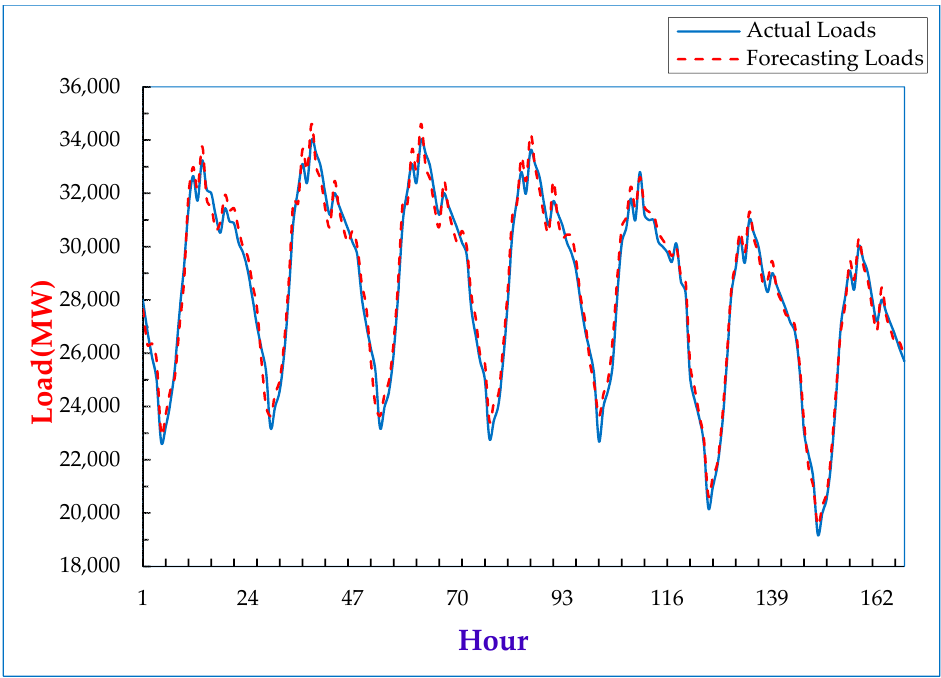
Figure 7. Load forecasting for the typical 2020 spring week (Monday 11 May 2020 to Sunday 17 May 2020).